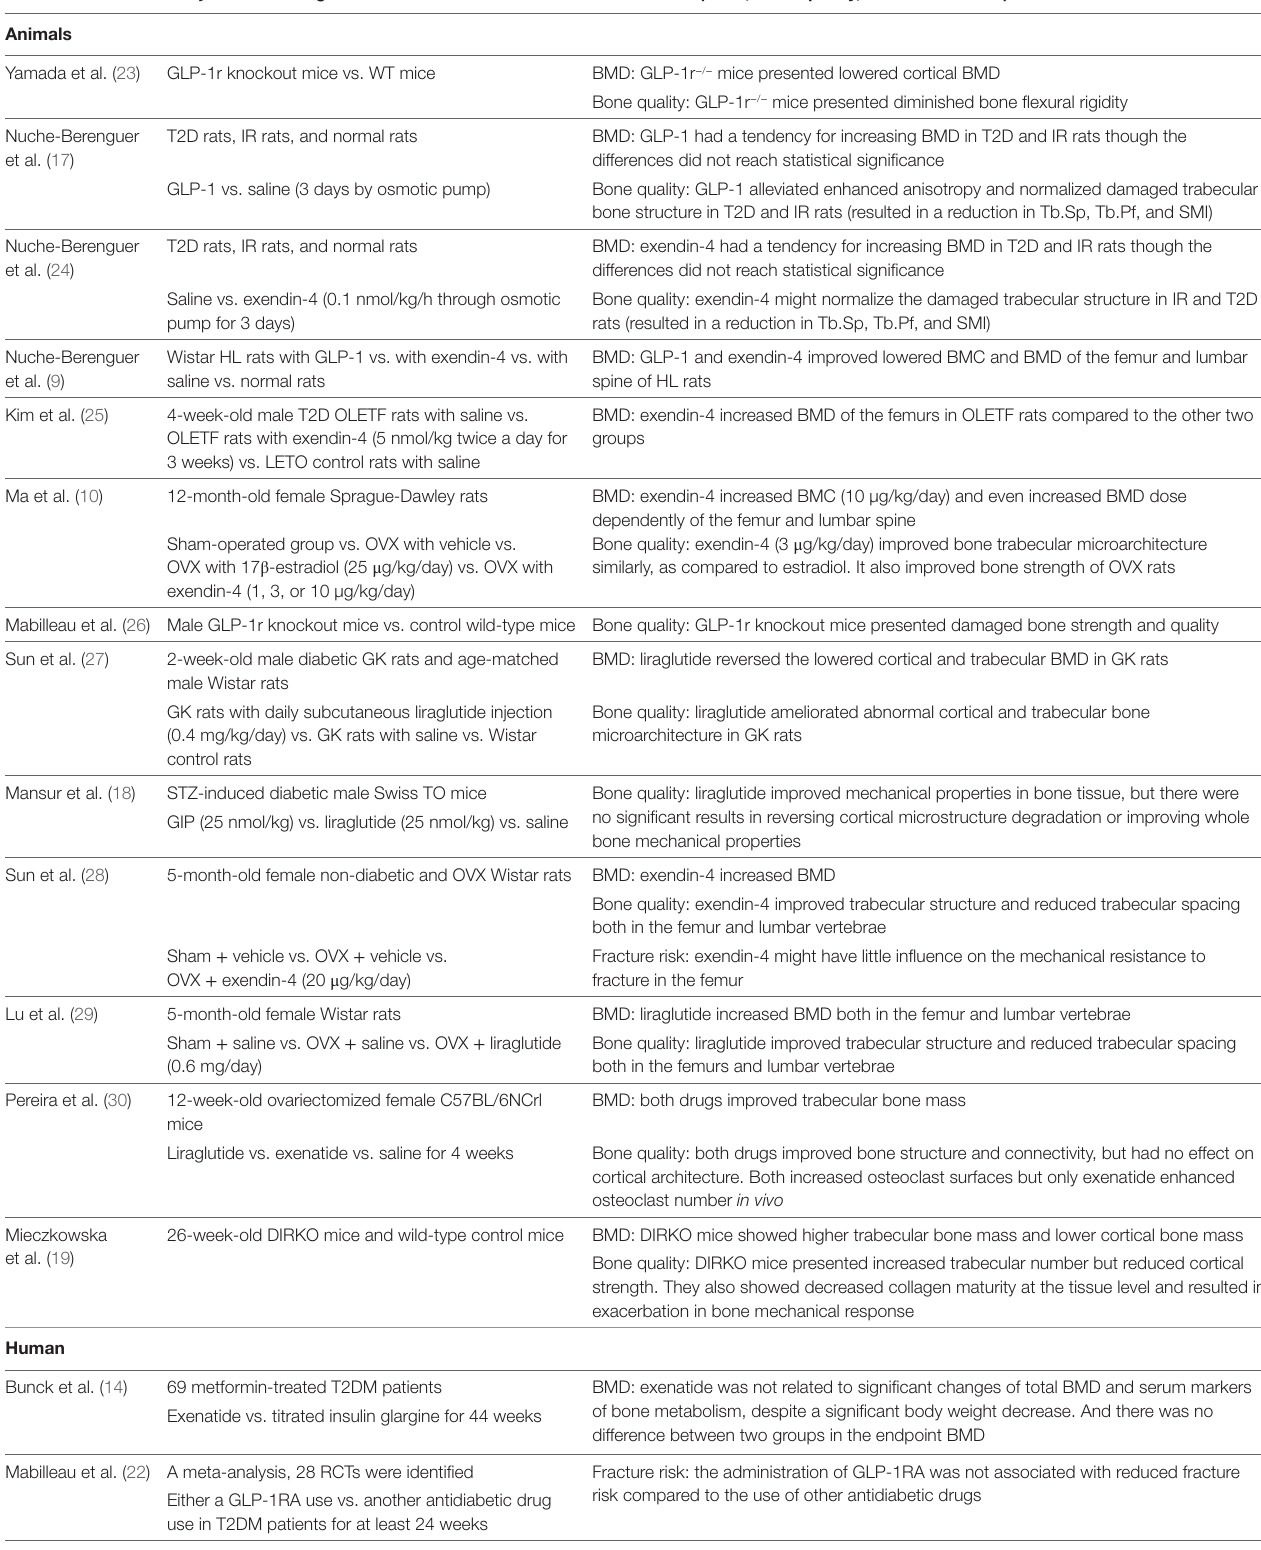
TABLe 1 | Published animal and human researches on the impact of GLP-1 on bone metabolism.